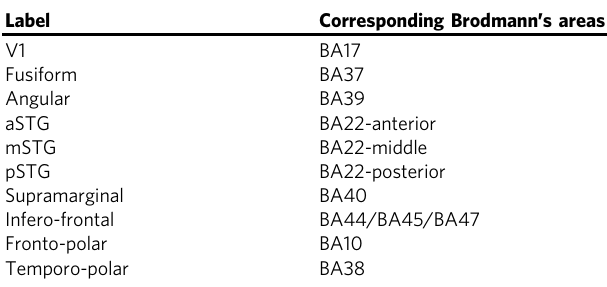
Table 1 Brain parcellation Taxonomy used to label the regions of interest in the brain following the